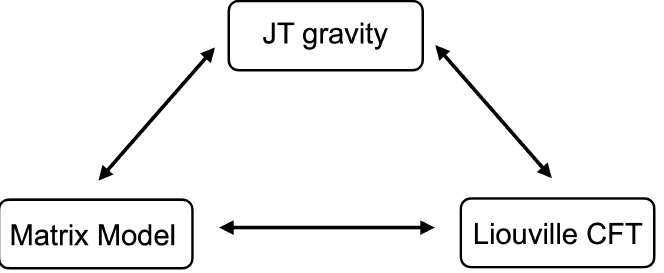
Figure 1 . The JT gravity triality: there are at least three descriptions of the JT gravity. The first is the two-dimensional quantum gravity coupled to a non-dynamical dilaton. This is the so-called JT gravity first studied by Jackiew and Teitelboim [6, 7]. The second is a certain double-scaled matrix model proposed by Saad, Shenker, and Stanford (SSS) [11]. The third is the Liouville CFT that is a two-dimensional quantum gravity coupled to a minimal model and the continuum description of the SSS matrix